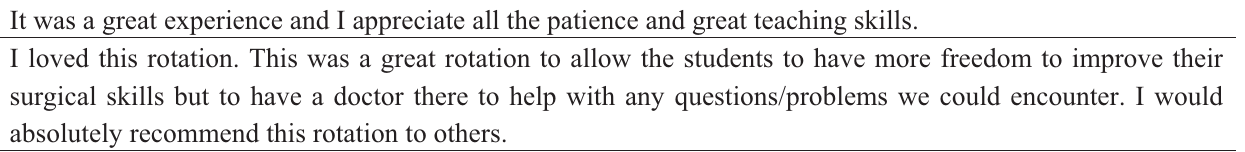
Table 5. Typical comments from senior veterinary